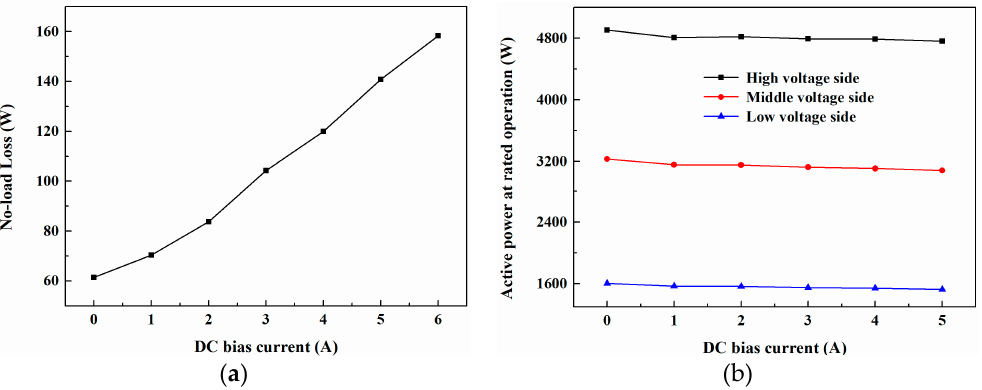
Figure 13. The measured losses and active power under various DC bias current. ( a ) no load loss. ( b )